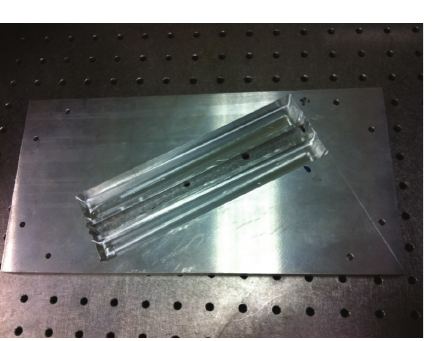
Figure 2: Picture of the diagonal groove rigid plate